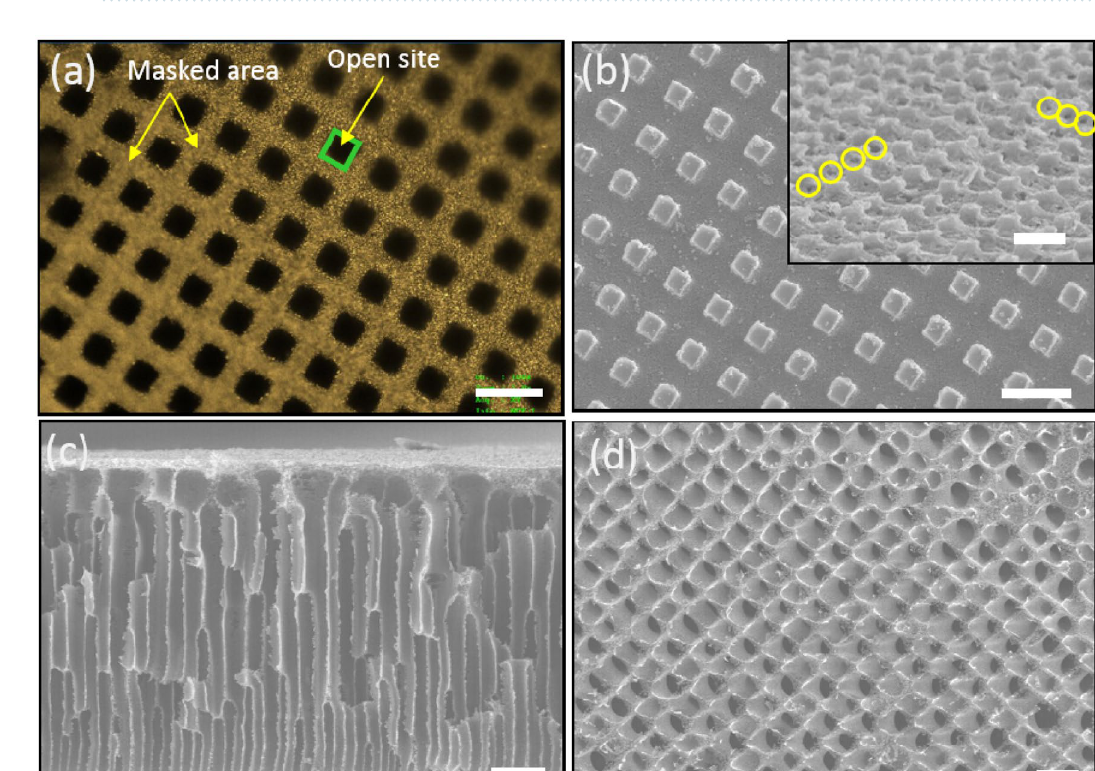
Figure 2. Confocal images of Cu mask ( a ) and SEM images of PEI polymer template ( b – d ): ( b ) top view of PEI template (inset: tilt image of PEI template, with yellow circles indicating the nucleation sites), ( c ) cross section of PEI template, and ( d ) highly aligned interior of PEI template after 5 min of oxygen plasma etching. The scale bar is 15